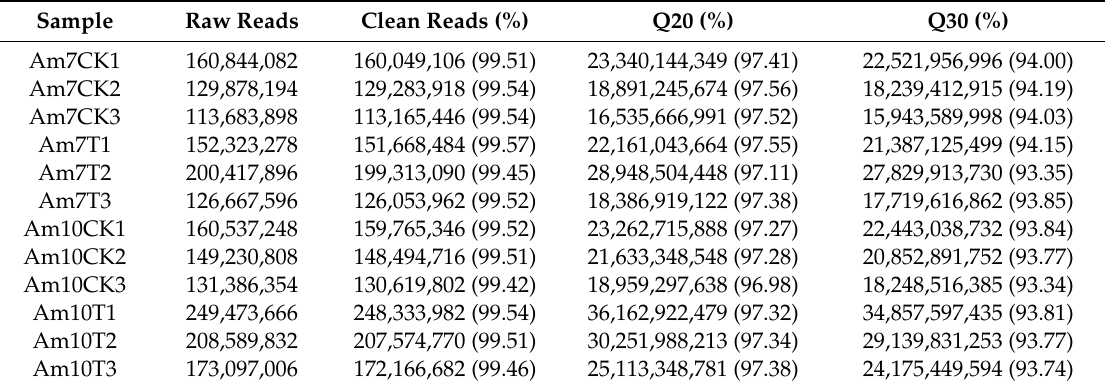
Table 1. Quality control of transcriptome data.